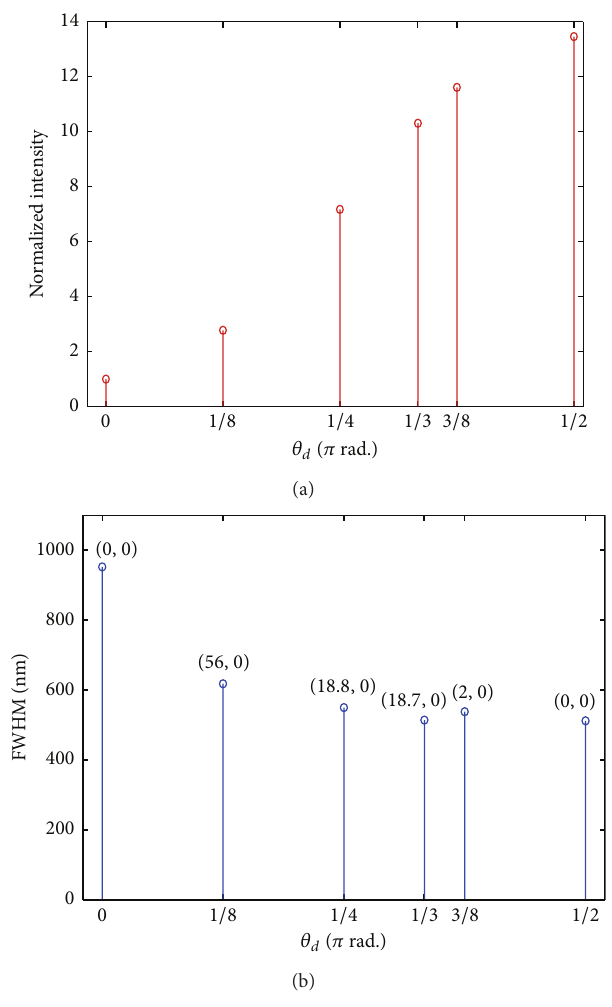
Figure 5: Central intensity (a) of spot and its FWHM (b) for the total intensity versus the pole angle of the dipole, where numbers atop each line denote the (𝑥,𝑦) coordinates of the spot